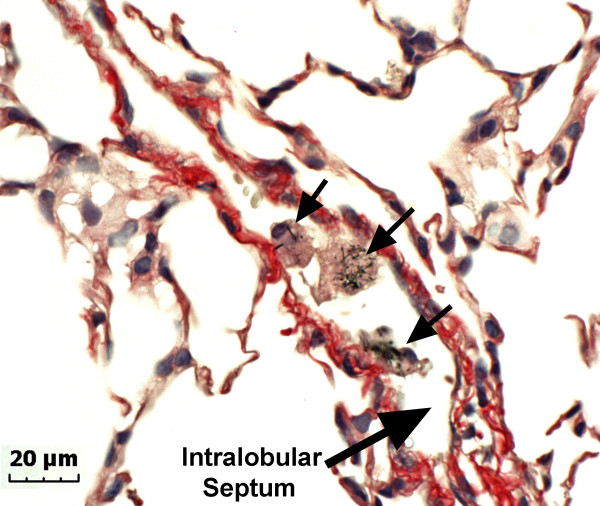
Photomicrograph of lung section showing an intralobular septum. This micrograph shows several MWCNT loaded macrophages (arrows) in the intralobular septum at 56 days post aspiration (40 μg dose).